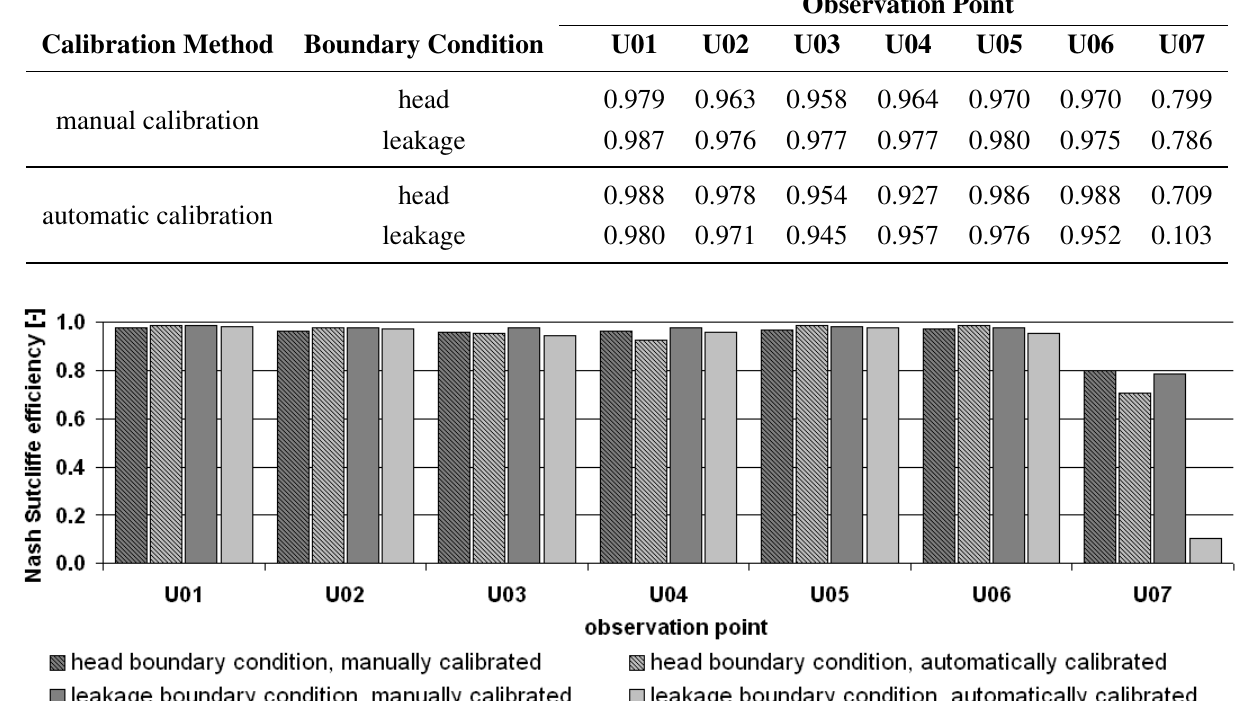
Figure 13. Graphical representation of the Nash–Sutcliffe efficiency (Table 4) for the observation points obtained with manual and automatic calibration for the two model